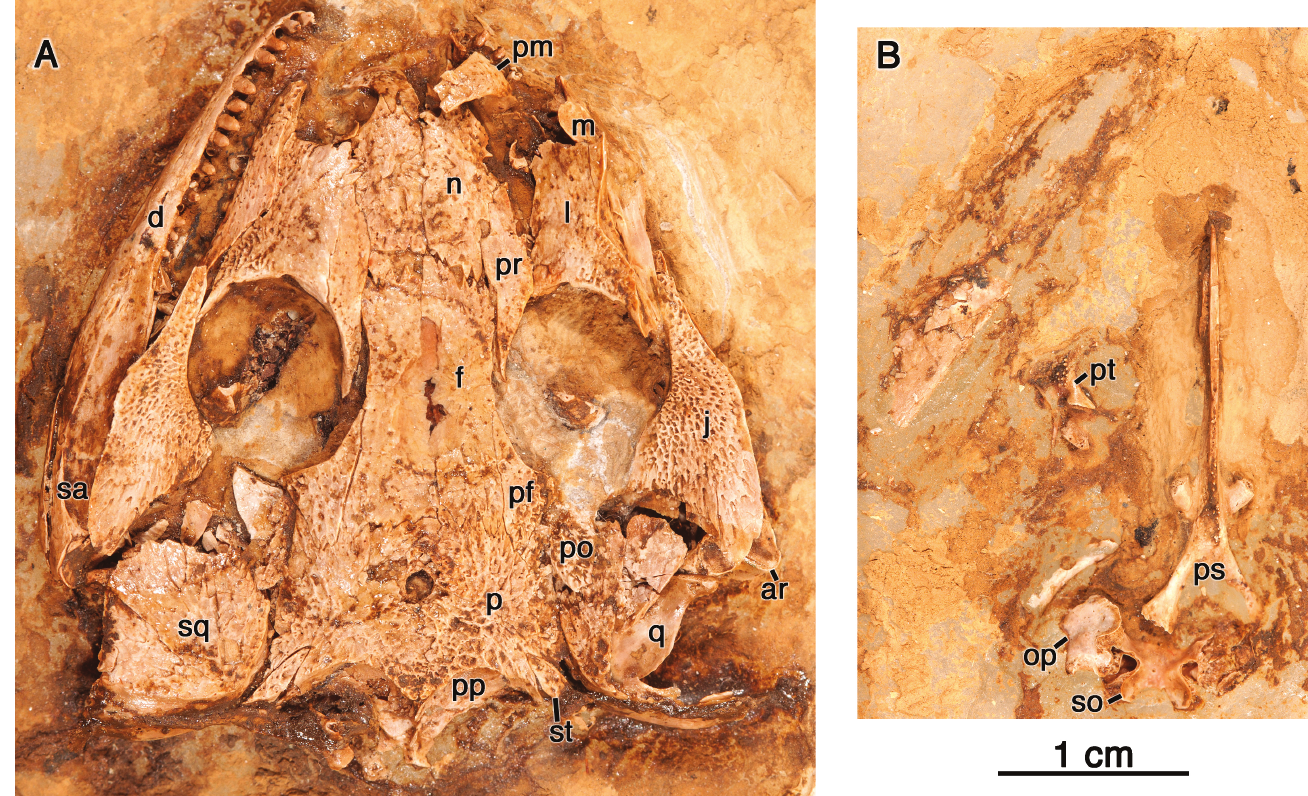
Figure 1. Euconcordia cunninghami , holotype, KUVP 87102a & b. A, skull roof exposed in dorsal view, with left mandible partially exposed and moved anterolaterally, with quadrate bone still partly in articulation with the articular bone. B, its counterpart, a partial, ventrally exposed braincase (This specimen was originally erroneously identified as KUVP 8702a & b). Abbreviations used in figures: ar, articular; bo, basioccipital; d, dentary; f, frontal; l, lacrimal; m, maxilla; n, nasal; op, opisthot - ic; p, parietal; pf, postfrontal; pal, palatine; pm, premaxilla; po, postorbital; pp, postparietal; ps, parasphenoid; pt,